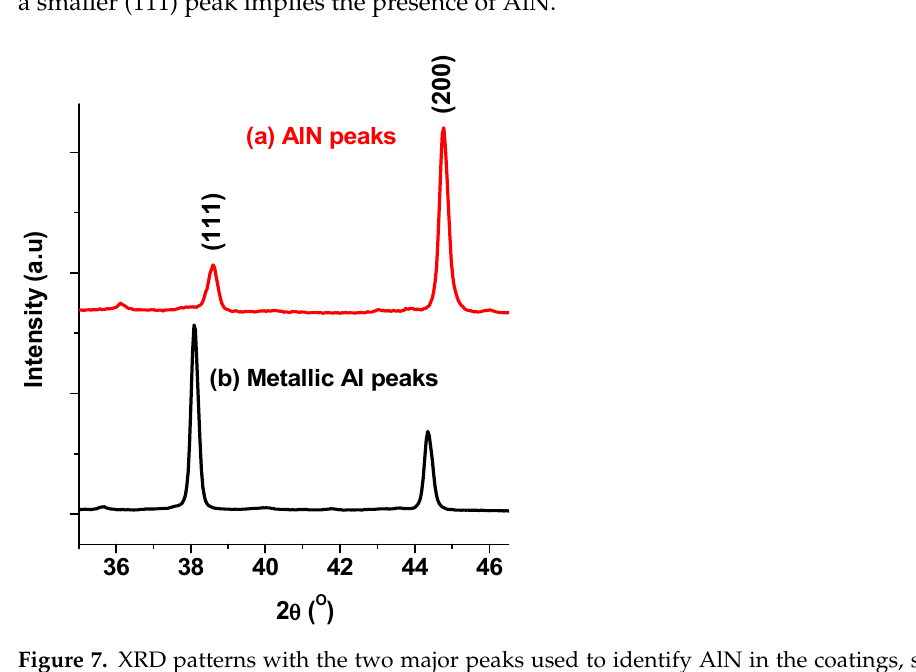
Figure 8. A typical result from the Rietveld quantitative analysis of a plasma synthesized sample. Further, the quantity of AlN (%) was plotted versus the standoff distance, the substrate materials, the liquid suspension carriers and the nitriding agents as provided in Figure 9. Figure 9a illustrates the impact the substrate materials have on the formation of AlN in the coatings, while Figure 9b shows that comparatively, melamine is a stronger nitridation agent than urea. The presence of oxygen in urea seems to have a negative